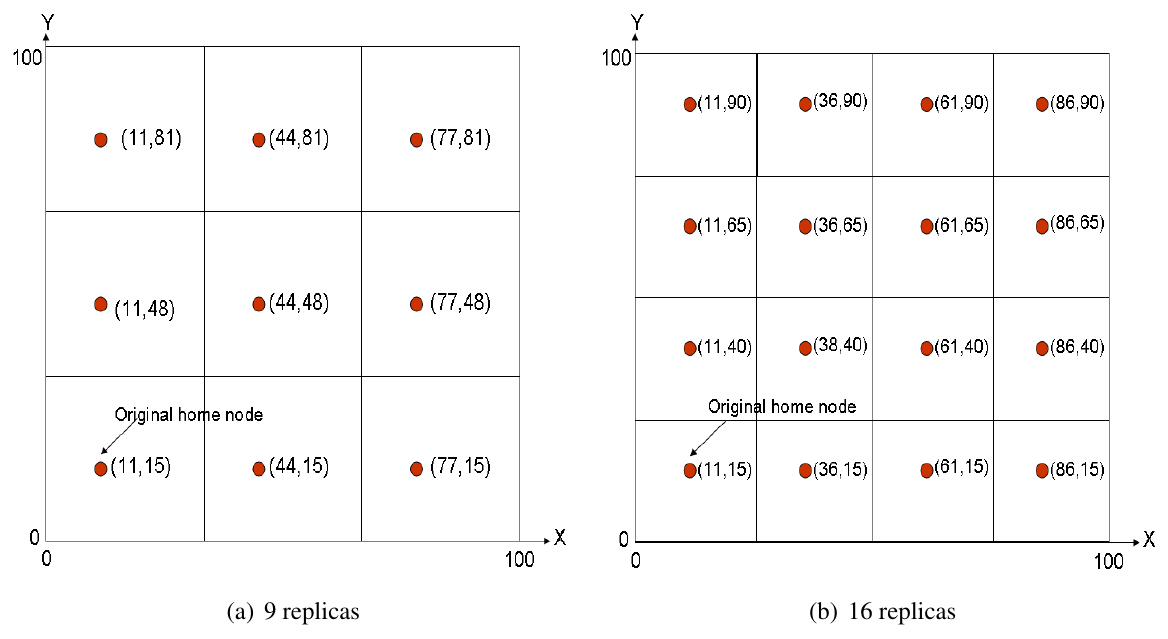
Figure 6. Multi-replication grid in Quadratic Adaptive Replication